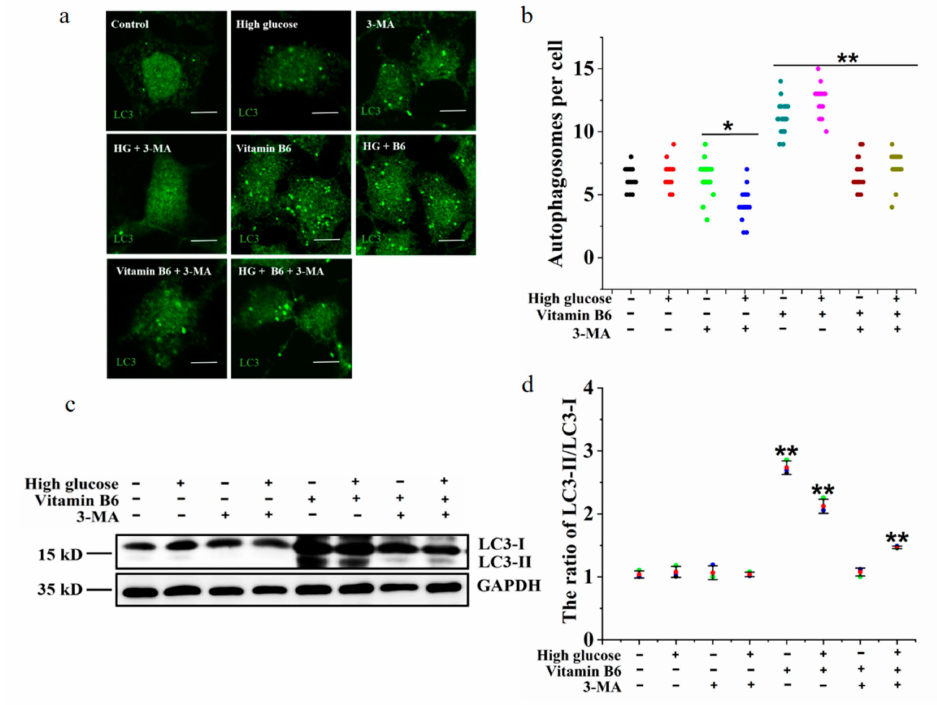
Figure 6. 3-MA inhibited vitamin B6-induced autophagy under high glucose stress. ( a ) RIN-m5F cells were maintained with or without 20 mM glucose or with 10 mM 3-MA, 20 mM glucose plus 10 mM 3-MA, 20 µ M vitamin B6, 20 mM glucose plus 20 µ M vitamin B6, or 20 mM glucose plus 20 µ M vitamin B6 plus 10 mM 3-MA, cultured for 36 h, and stained with anti-LC3 antibody (scale bar = 5 µ m). ( b ) Cells were treated as described in ( a ), and the number of autophagosomes per cell was counted. At least 30 cells were analyzed. The experiment was repeated at least three times (Error bars, SD. ** p < 0.01, * p < 0.05 indicates significant differences compared with the control group by one-way ANOVA. ( c ) Cells were treated as described in ( a ), and Western blotting was performed to test the expression of proteins with specific antibodies against LC3 and GAPDH. ( d ) The LC3-II/LC3-I ratio in ( c ) was analyzed by IOD using Image-Pro Plus 6.0